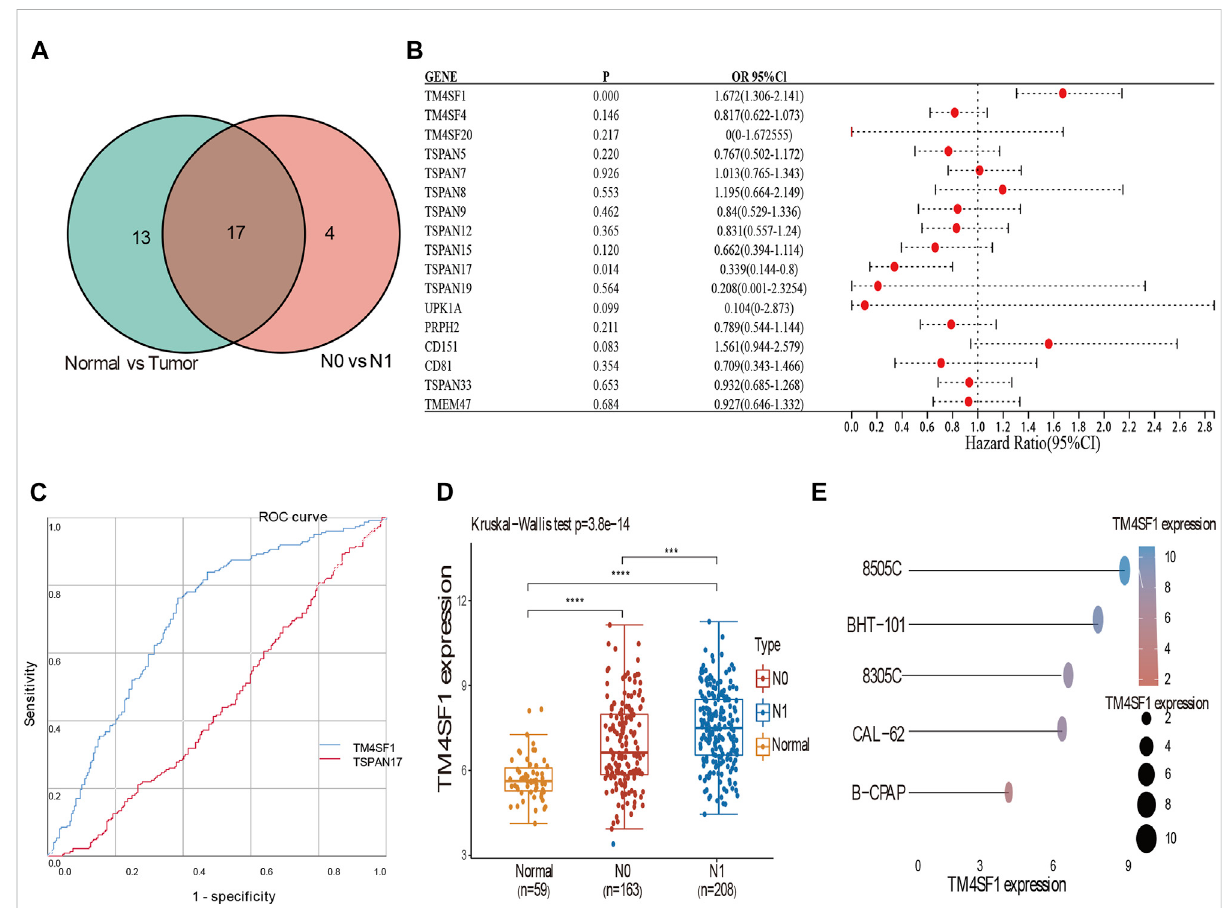
FIGURE 4 Binary logistic regression and ROC analyses suggested TM4SF1 as an indicator of LNM in PTC. (A) Veen diagram of the intersection of these DEGs among tumor vs. normal, N0 vs. N1; (B) Forest plot of data from the binary logistic regression analysis revealing genes (TSPAN17, TM4SF1) independently associated with LNM in PTC ( p < 0.05); (C) ROC curve analyses of TM4SF1 (AUC = 0.702) and TSPAN17 (AUC = 0.555) to assess the diagnostic value in LNM ( p < 0.05); (D) Expression of TM4SF1 mRNA in N0 vs N1 vs Normal group ( p < 0.05); (E) The expression distribution of TM4SF1 mRNA in different thyroid cancer cell lines. The abscissa represents the expression distribution of mRNA and the ordinate represents different cell lines, different colors and the size of dots represent